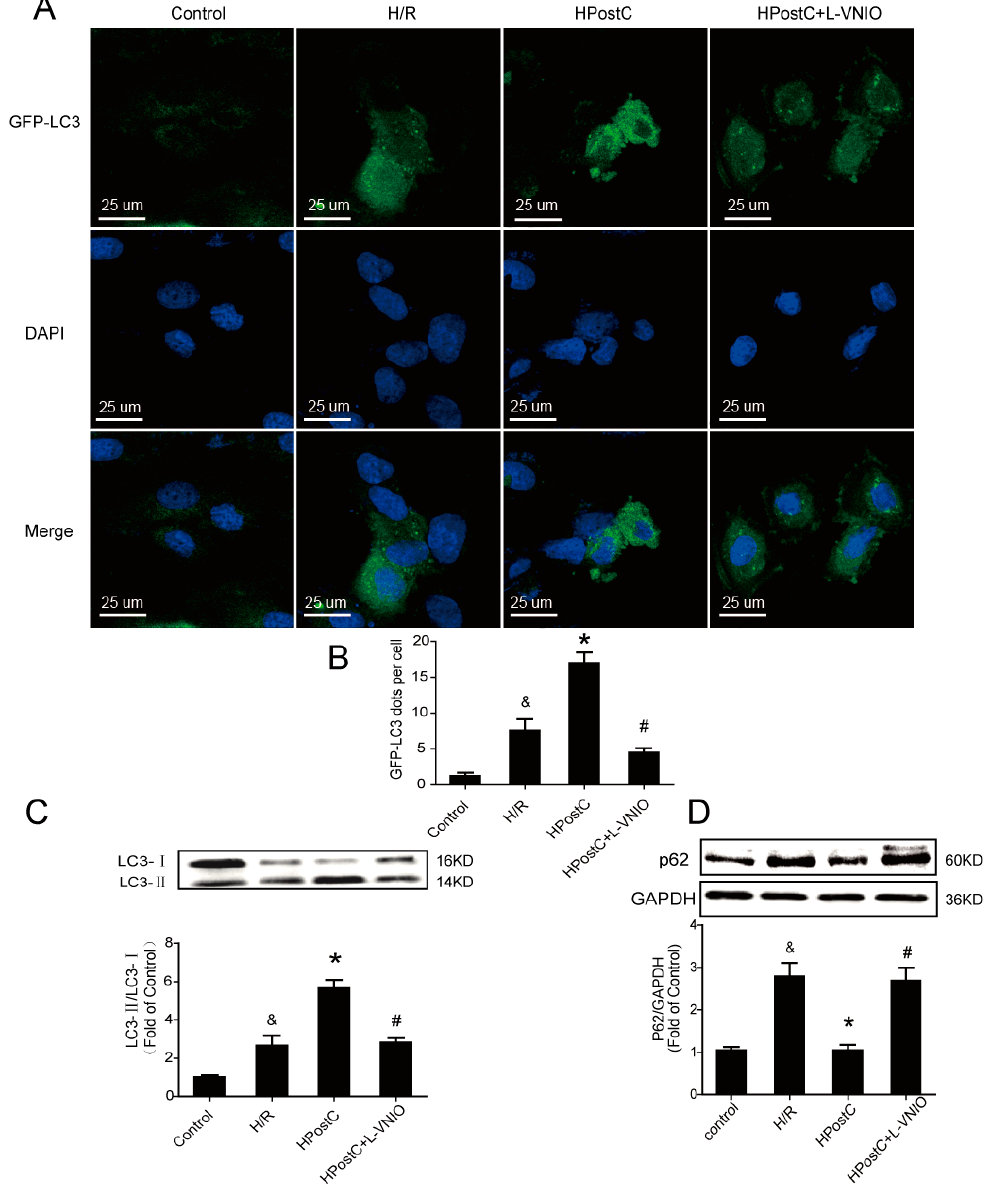
Figure 3. Hypoxic postconditioning (HPostC) enhanced autophagic activity via nNOS in H9c2 cells; ( A ) H9c2 cells were infected with GFP-LC3 adenovirus. The nuclei were labeled with DAPI (blue); ( B ) The statistics of GFP-LC3 dots; ( C ) Expression of LC3 in H9c2 cells at 30 min of reoxygenation; ( D ) Expression of p62 at 30 min of reoxygenation. & p < 0.05 versus control, * p < 0.05 versus hypoxia/reoxygenation (H/R), # p < 0.05 versus HPostC. The mean values ± SEM, n = 6.